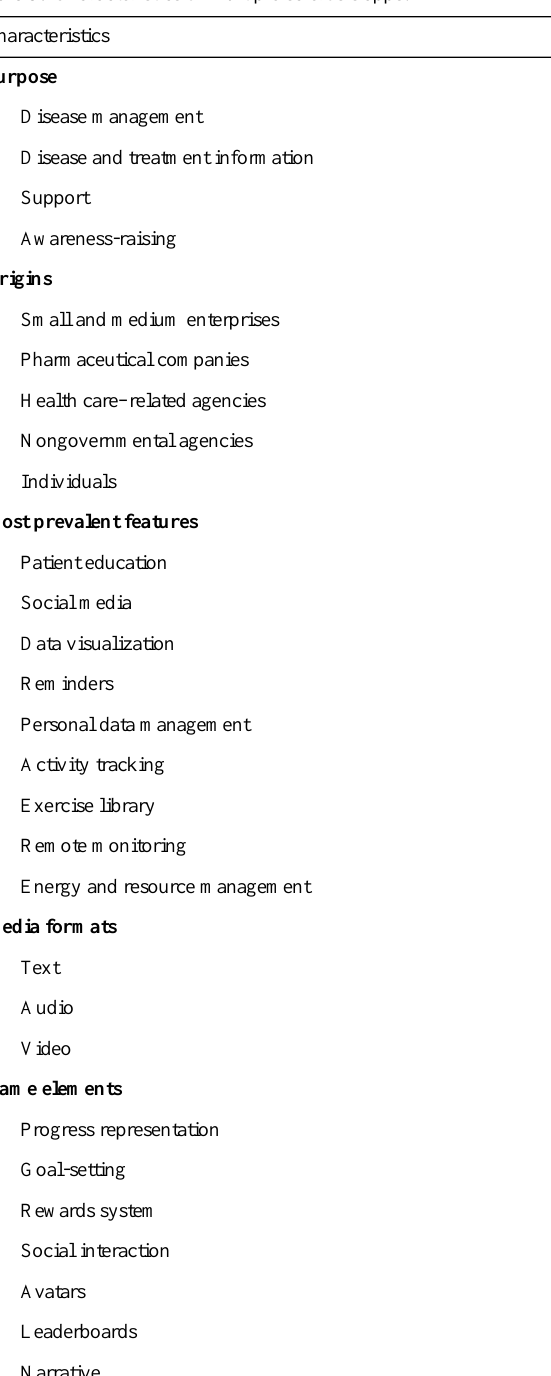
Table 3. Characteristics of multiple sclerosis